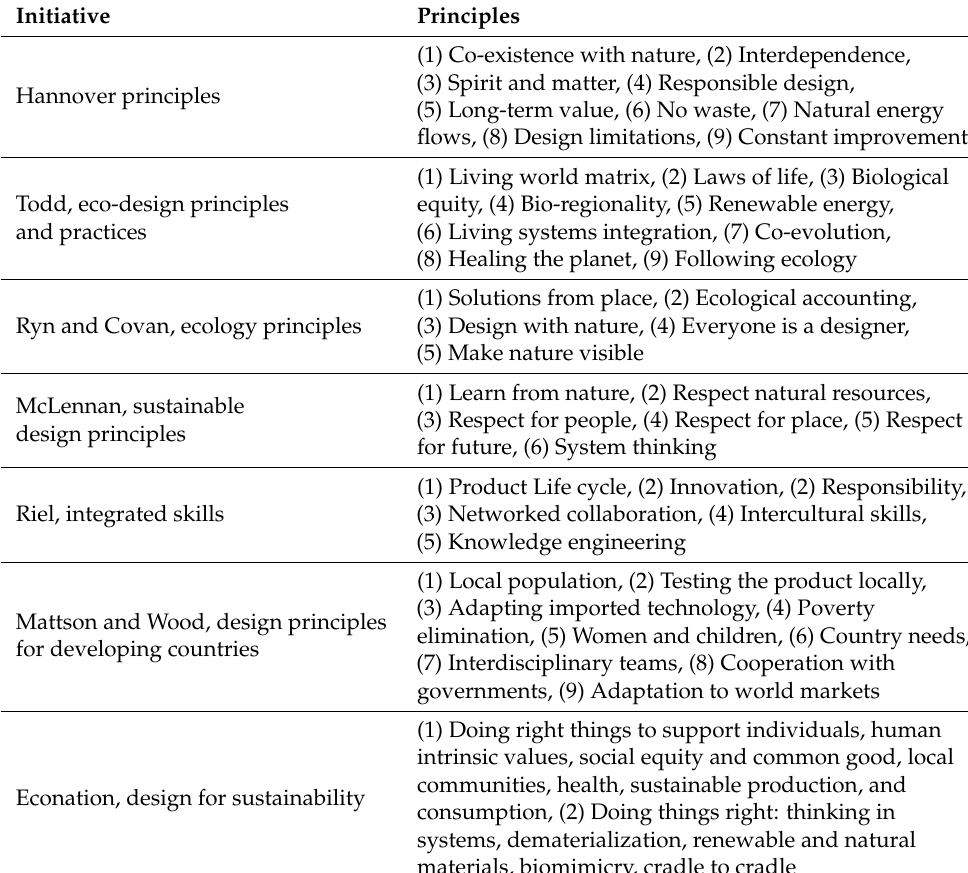
Table 2. An overview of sustainable design principles on the time axis.